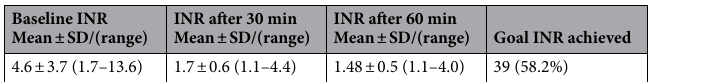
Baseline INR Mean ±